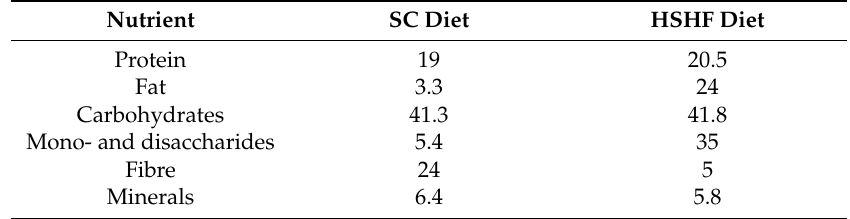
Table 7. Comparison of the composition of standard chow (SC) diet and TestDiet 58Y1/5APC (high-sucrose/high-fat (HSHF) diet). Nutrient SC Diet HSHF